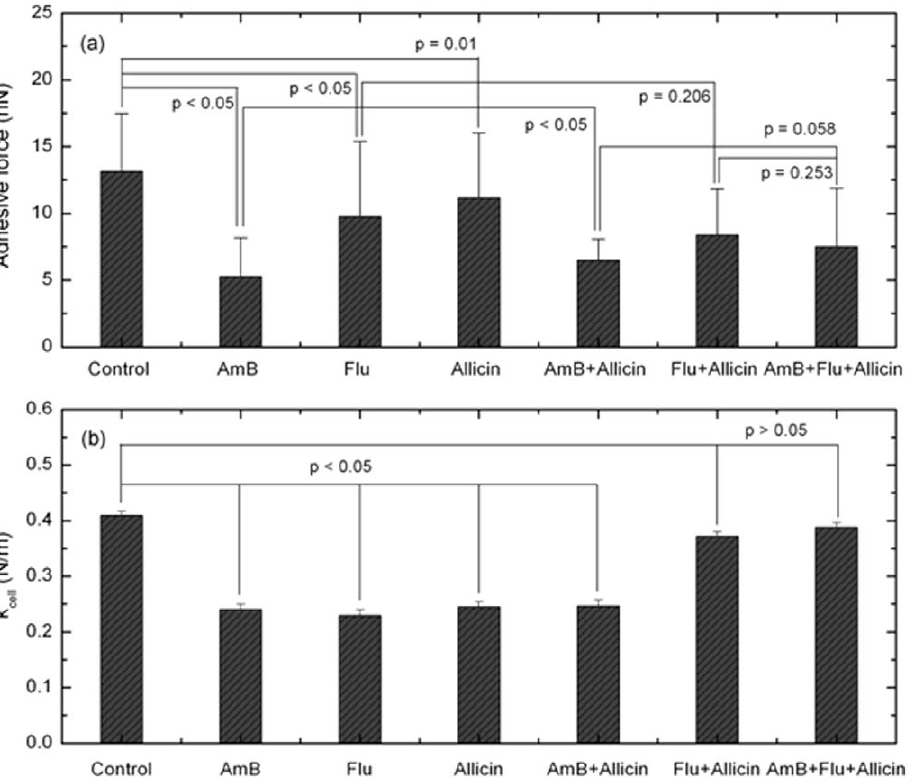
Figure 5. Changes in the biophysical properties of C.albicans according to treatment condition. (a) Changes in the adhesive force between the cells surface and the AFM tip and (b) changes in the stiffness of the cell membrane.